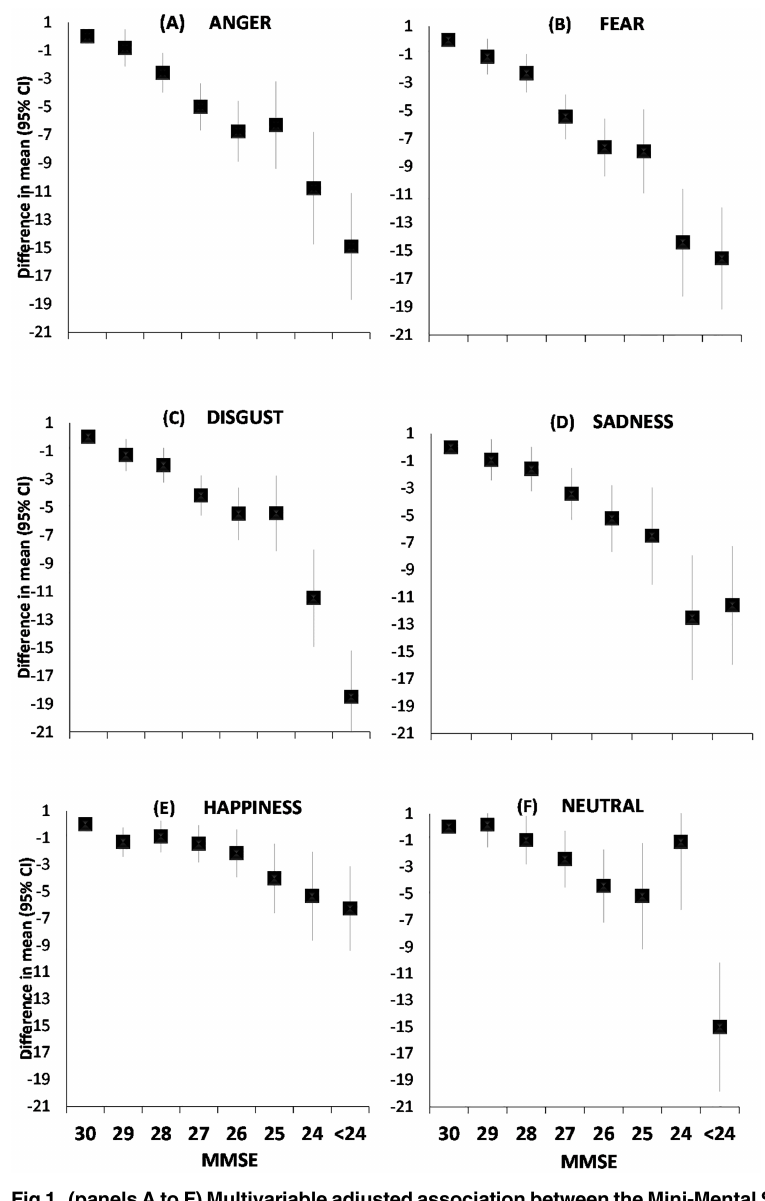
Fig 1. (panels A to F) Multivariable adjusted association between the Mini-Mental State Examination (MMSE) cognitive function test score and accuracyof emotion recognition in the Facial Expression Recognition Task (FERT) a . a Point estimates are mean and error bars 95% confidenceintervals. Models are adjustedfor age, sex, educational level, depressivesymptoms, and antidepressant use.